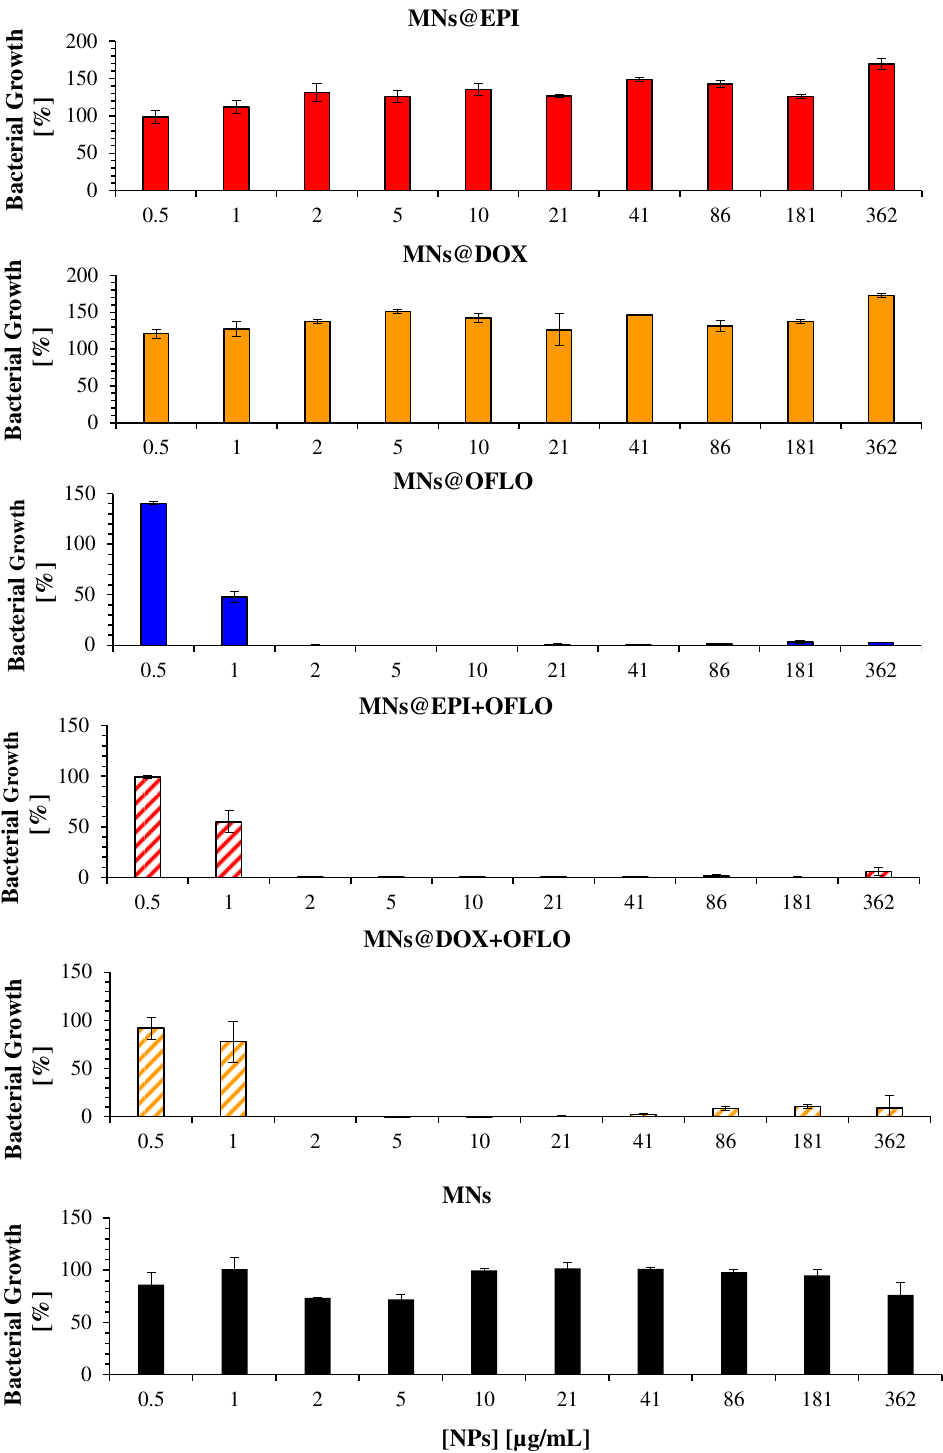
Figure 5. Antimicrobial activity of drug-loaded MNs on the parental E. coli strain, measured as the bacterial growth calculated by OD 600 , for 24 h assay.